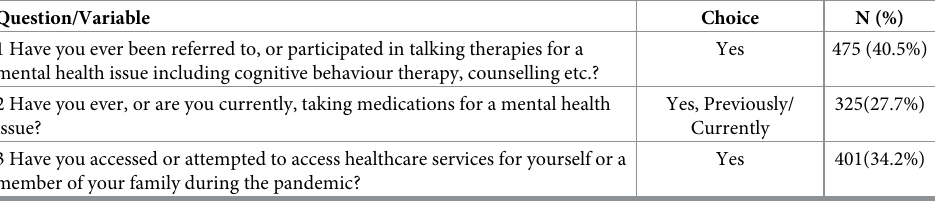
Table 3. Brief mental wellbeing history descriptive analysis.